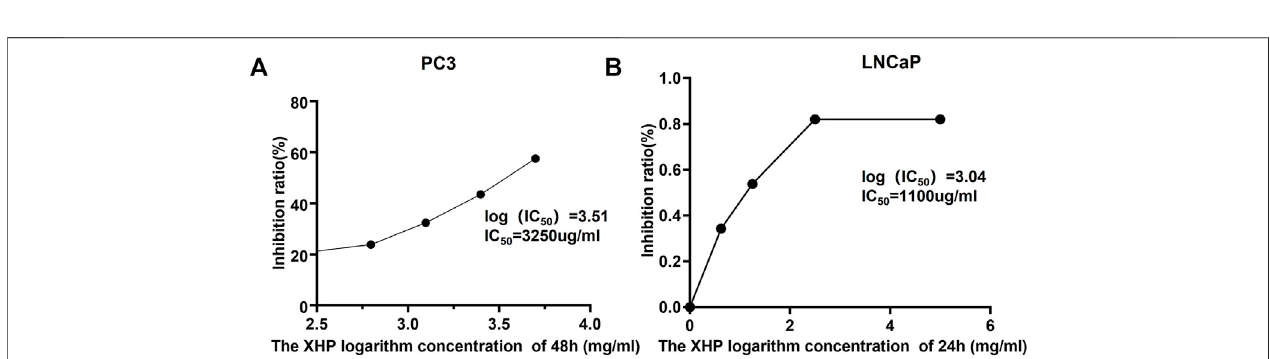
FIGURE 5 | The IC 50 of XHP to PC3 and LNCaP cells in 48 and 24 h, respectively.(IC 50 , The half maximal inhibitory concentration).